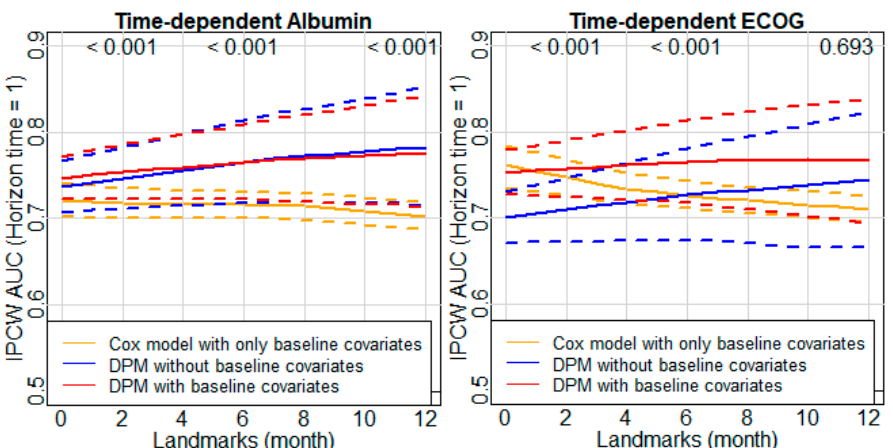
Figure 3. IPCW AUC and 95% CIs for survival prediction at horizon time 1 month from models using time-dependent albumin ( left ), and ECOG PS ( right ). p values at the top of each plot are for comparing the DPM using both the time-dependent variable and baseline covariates and the baseline Cox model at landmarks of 2, 6, and 12 months.